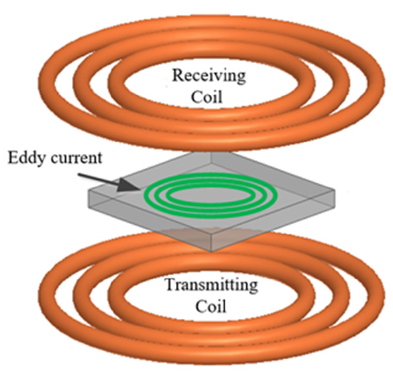
Figure 1. Metal foreign object and eddy current.